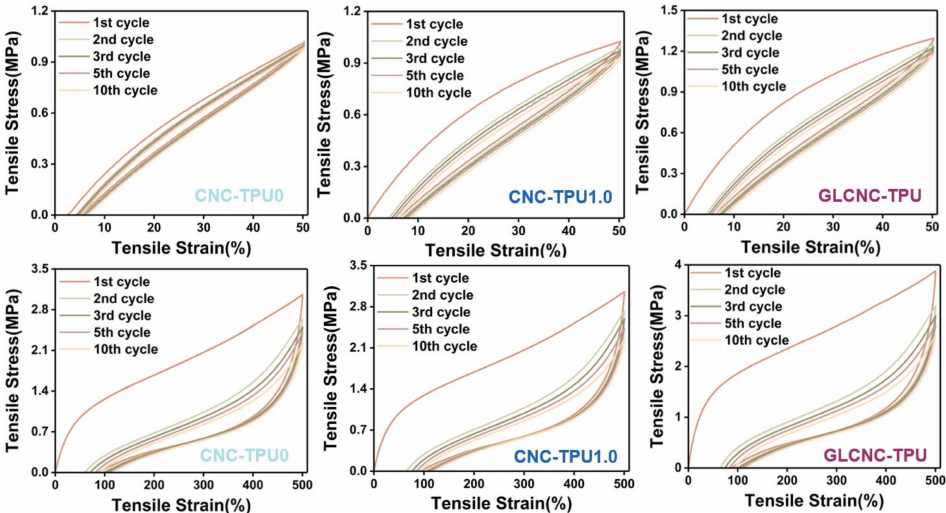
Figure 6. Stress–strain curves of CNC-TPU 0, CNC-TPU 1.0, and GLCNC-TPU composite films under cyclic loading at 50% and 500%